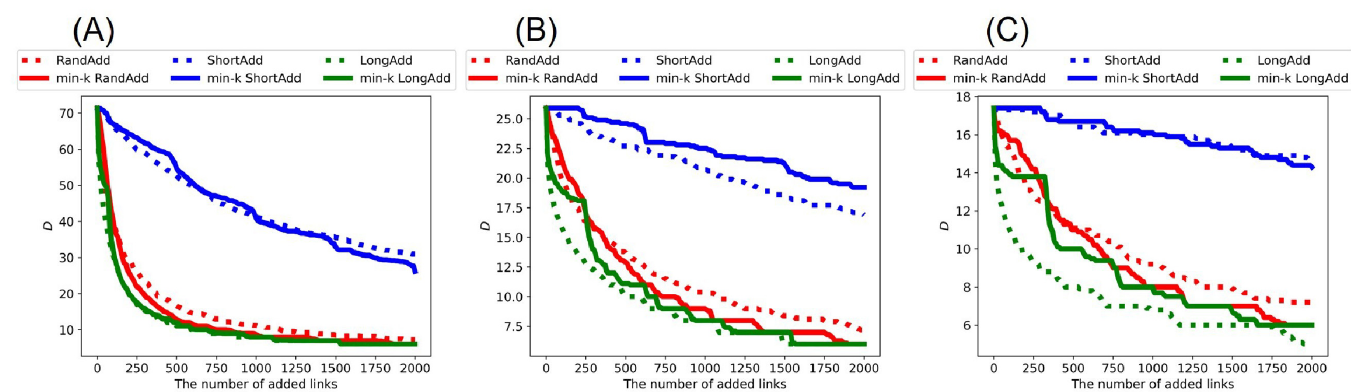
Fig 12. Diameter after adding links to random trees. The LongAdd method (green dotted line) is the most effective for decreasing D among the six methods. The ShortAdd and min- k ShortAdd method (blue dotted and solid lines) are higher than other four methods. The initial random tree has (A) narrower, (B) exponential, and (C) power-law degree distributions. The correspondence between lines and methods is the same as in Fig 2.